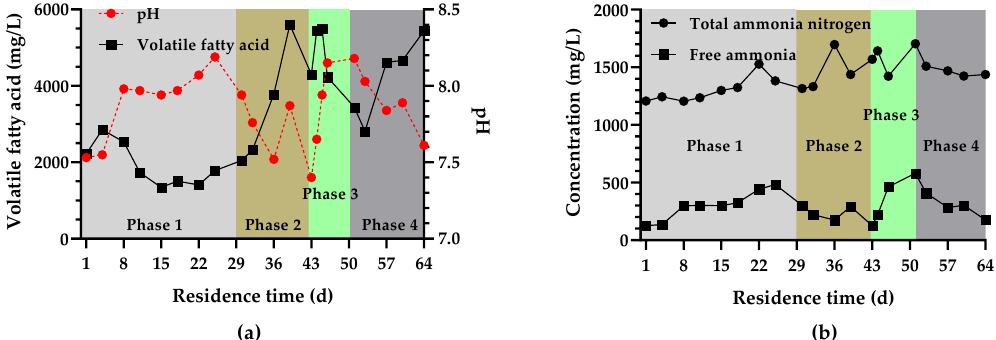
Figure 6. Volatile fatty acid (VFA), pH value ( a ) and total ammonia nitrogen (TAN) and free ammonia contents ( b ) of digestate during anaerobic digestion process.